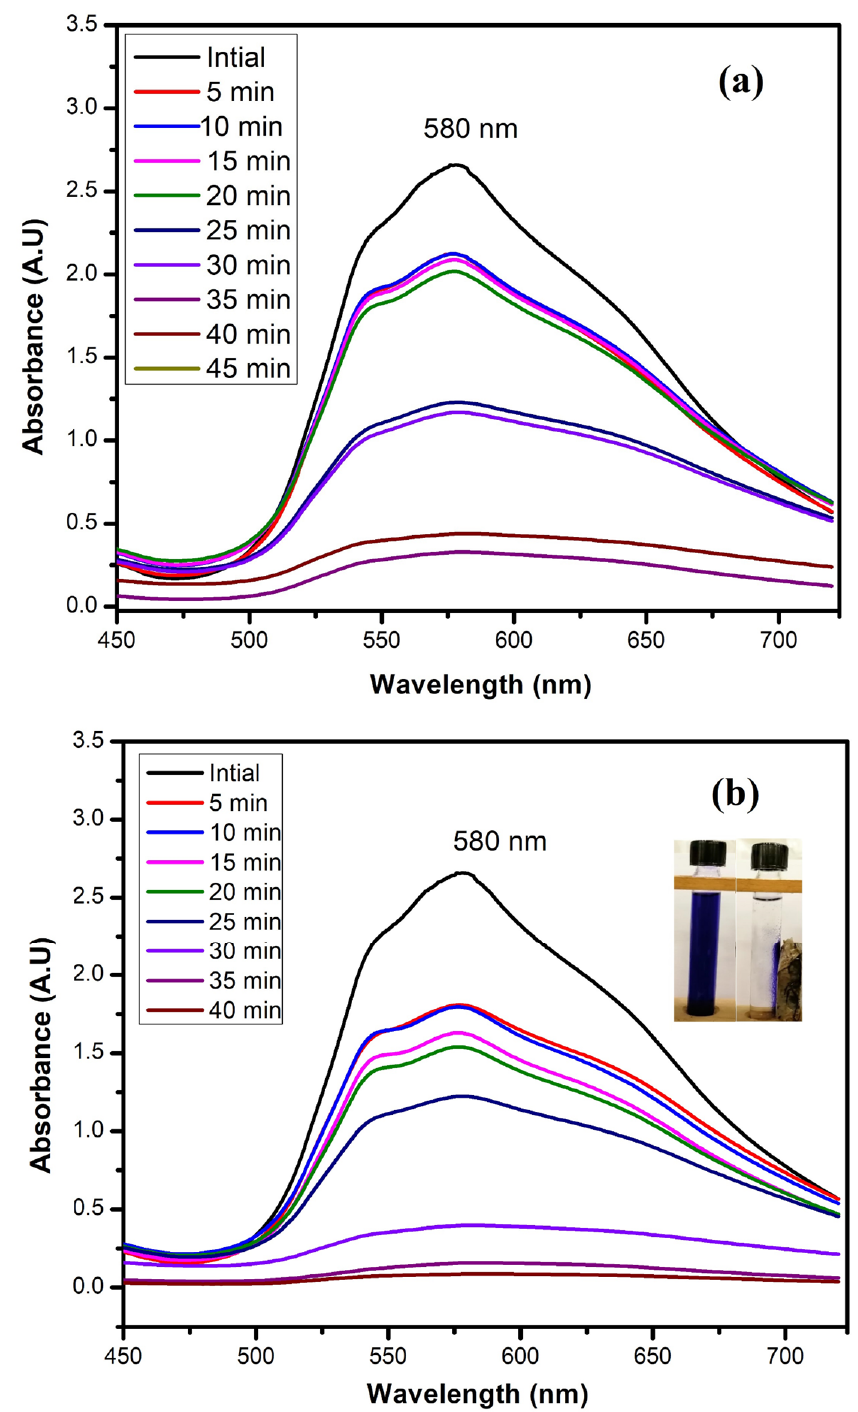
Figure 10. UV/Vis spectra of CBB dye solution in contact with ( a ) CQVP/MA and ( b ) CQVP/MA- Fe 3 O 4 as a function of time.